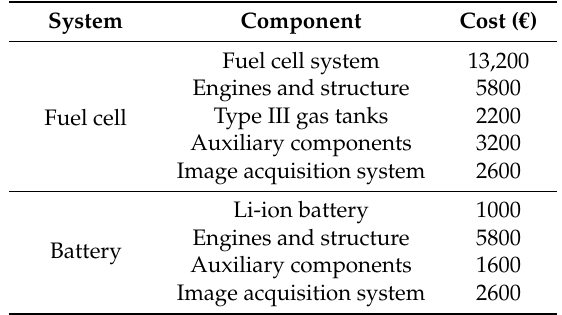
Table 2. Costs of the main components for the mobile systems.